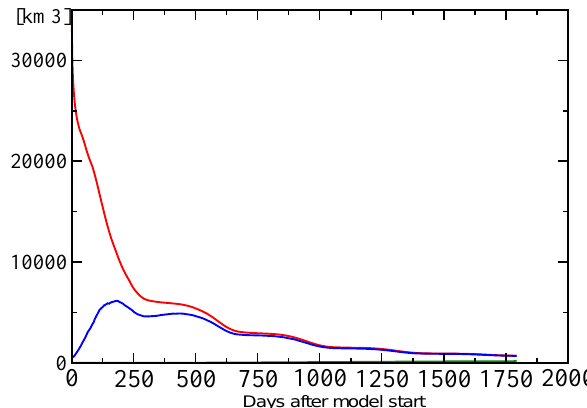
Fig. 10. Inventory of marked North Sea water in experiment MARKER. An average over all ensemble members is shown. The red line indicates the total ocean inventory. The blue line indicates open ocean inventory without the North Sea and green line indi- cates the deep ocean inventory below 1000m water depth. The inter- ensemble variability is very low compared to the mean